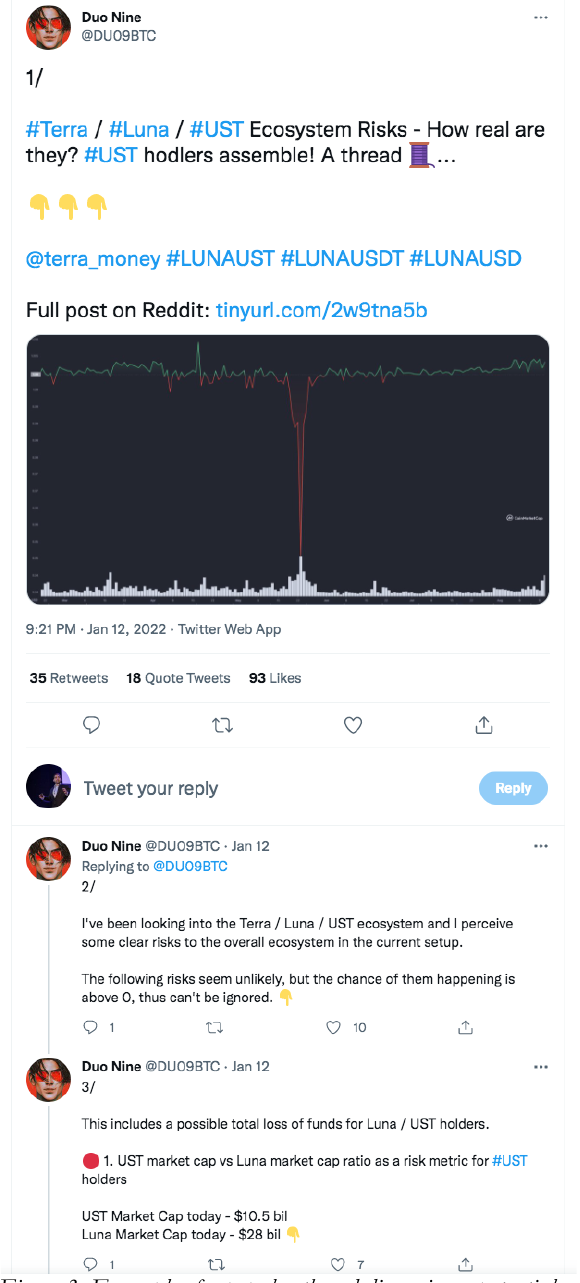
Figure 3. Example of a popular thread discussing a potential scenario was Terra/Luna crashes. Source: